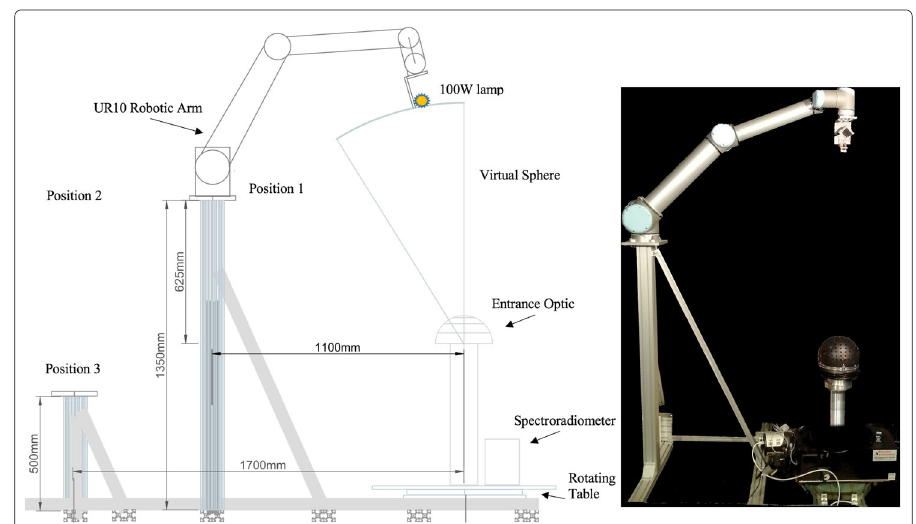
Fig. 5 Experimental setup for the angular response measurements of a multi-directional input optics. Three mounting points are used for the same robot, Position 1 for the upper area between 0° and 36°, Position 2 (using the same aluminium-profile as Position 1 but fixed on Position 3 base) for the section between 36° and 60°, and Position 3 for the lower area between 60° to 90°. A rotation table is used to measure the radiance in different azimuthal sections